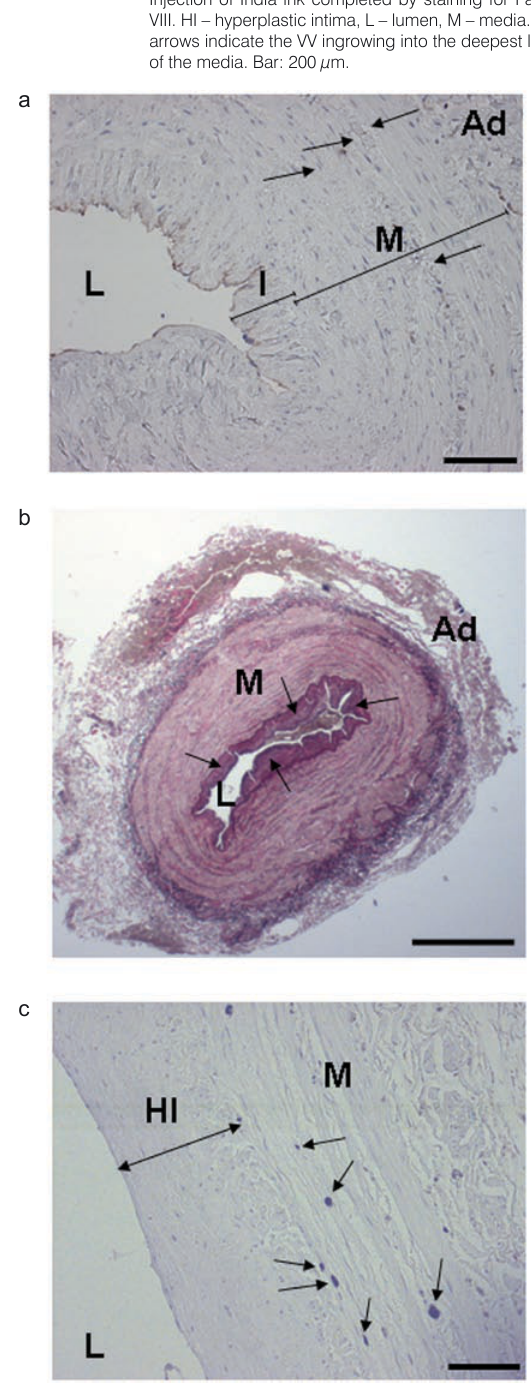
Figure 2. a. Detail of the cross section of the non-varicose GSV. Injection of India ink. I – intima, L – lumen, M – media, Ad – adventitia. The arrows indicate the VV in the outer two-thirds of the media. Bar: 200 μm. b. Cross section of the stem of non-varicose GSV. Staining for elastin. Ad – adventitia, L – lumen, M – media. The arrows designate regions with an extensive intimal hyperplasia. Bar: 500 μm. c. Detail of the cross section of the non-varicose GSV. Injection of India ink completed by staining for Factor VIII. HI – hyperplastic intima, L – lumen, M – media. The arrows indicate the VV ingrowing into the deepest layer of the media. Bar: 200